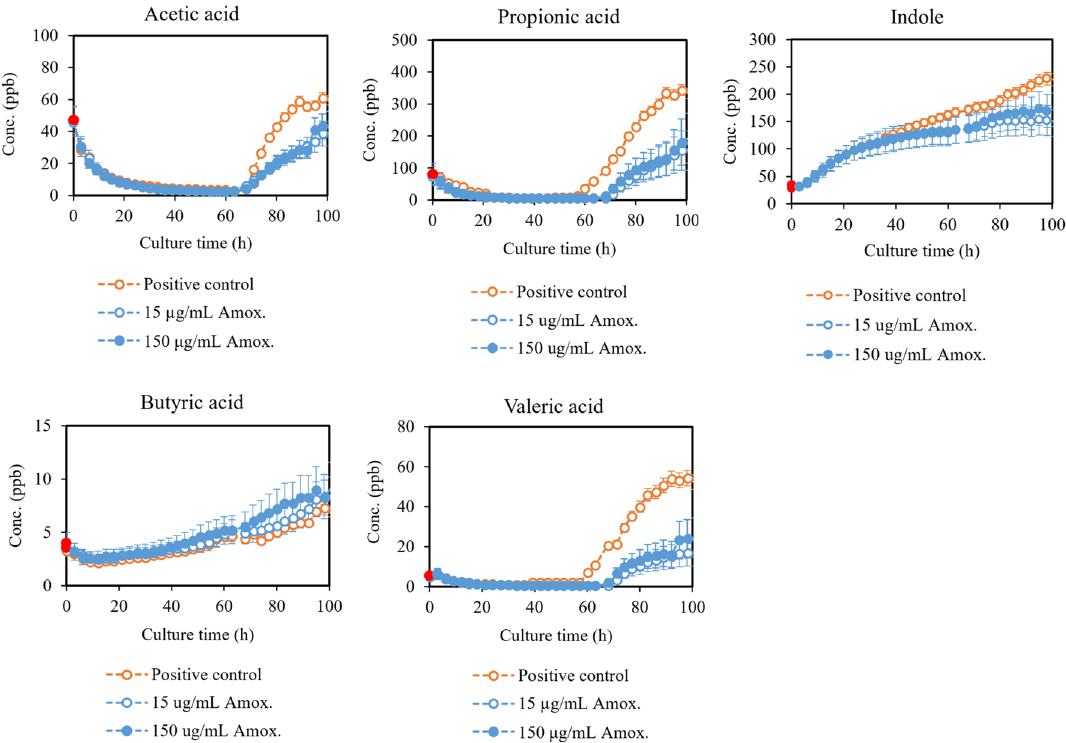
Figure 2. Most important volatile short- and medium-chain fatty acids and indole produced by P. gingivalis untreated (positive control) and treated with amoxicillin. The time of antibiotic addition is marked in red. Concentrations are given as the mean ± SD of triplicate measurements (N = 3). Additional production profiles (caproic, 2-methylhexanoic, and caprylic) can be found in the Supplementary information (Fig.